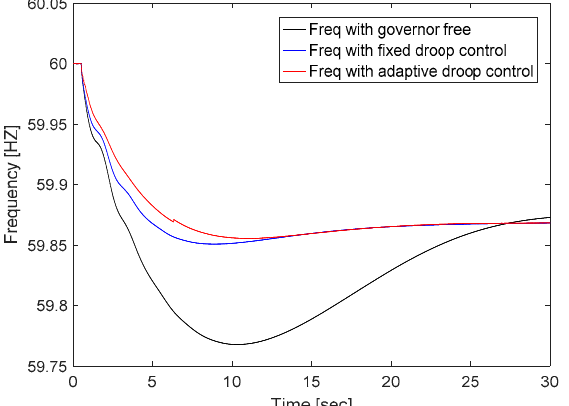
Figure 11. Comparison of system frequency with generator trip.